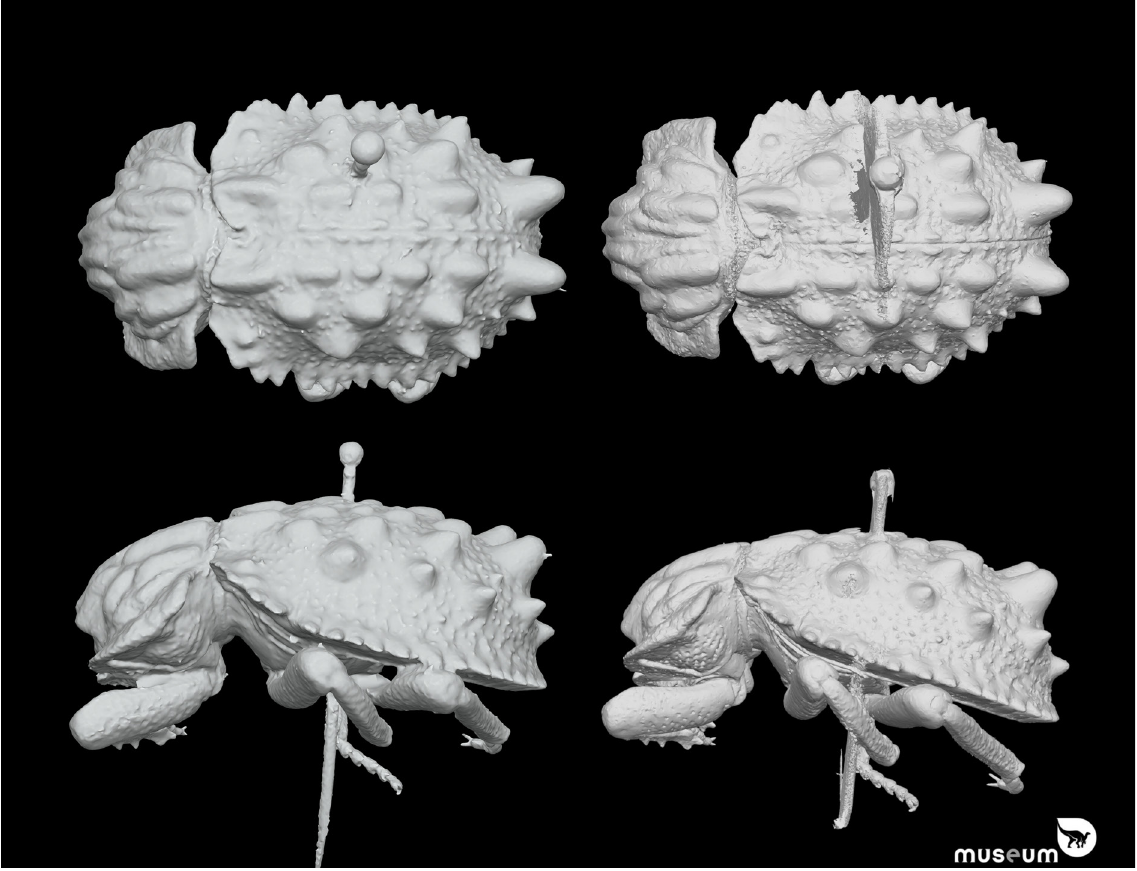
Fig. 6.11. Comparison between the Focus Stacking Photogrammetry model (left) and the µCT model (right) of the Omorgus beetle. The models are very close, with the µCT model perhaps showing a little more detail. The µCT scan was made using a XRE UniTom at 60 kV and with a voxelsize of 29 µm.